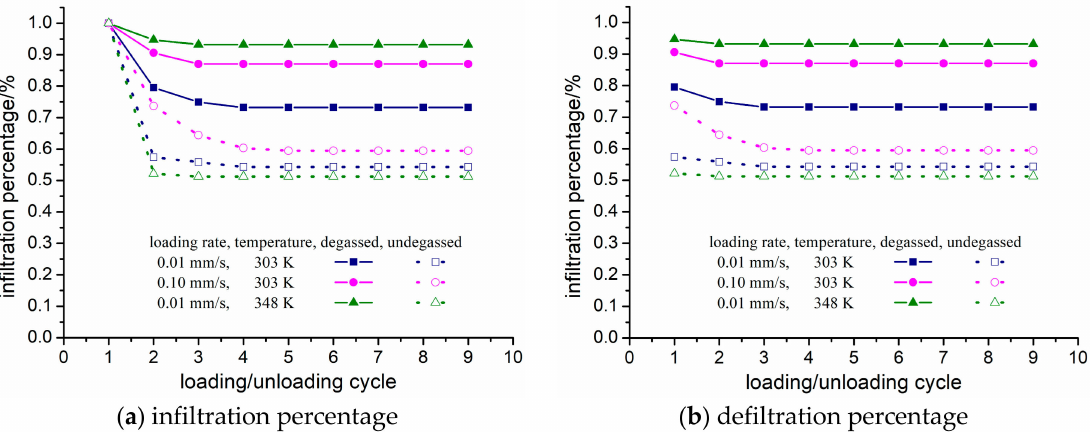
Figure 6. Comparison of the infiltration and defiltration percentage of undegassed and degassed glycerol/zeolite system (loading rate 0.01 mm/s and 0.10 mm/s; system temperature 303 K and 348